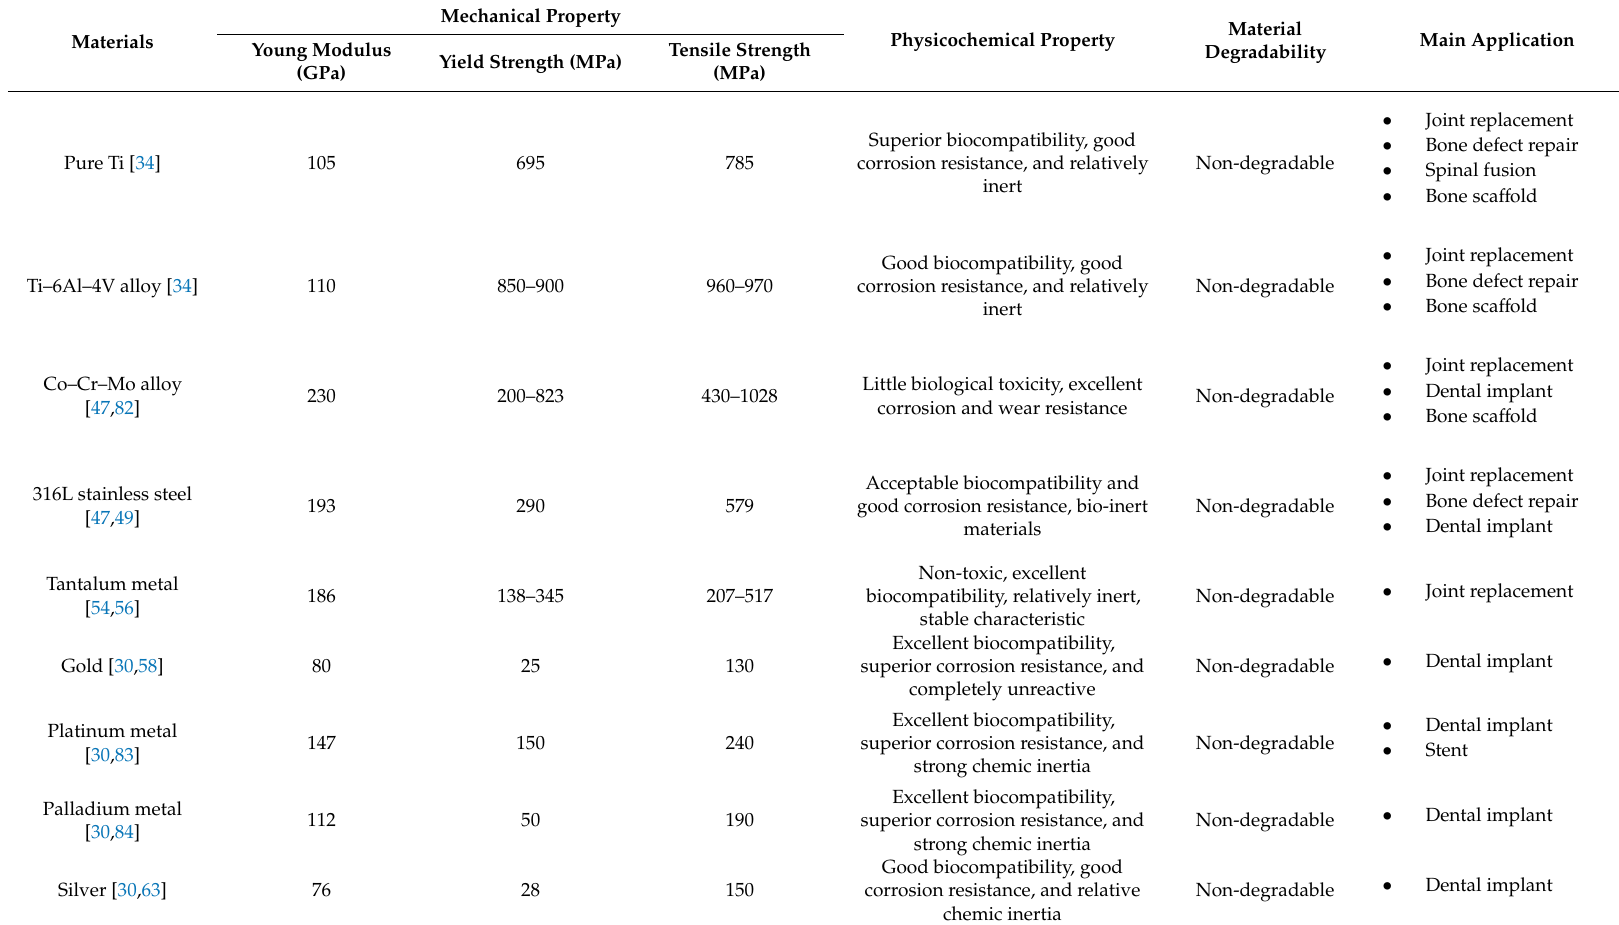
Table 1. The properties of di ff erent biomedical